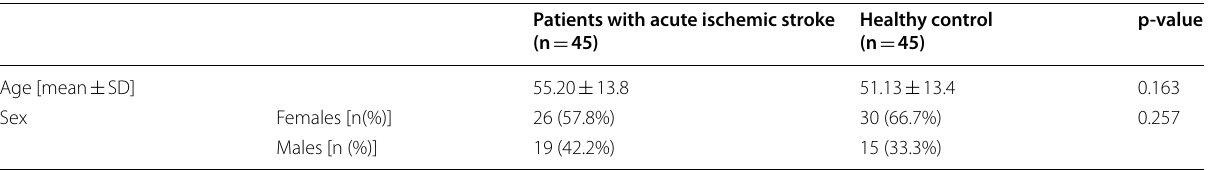
Table 1 Demographic data of the studied population